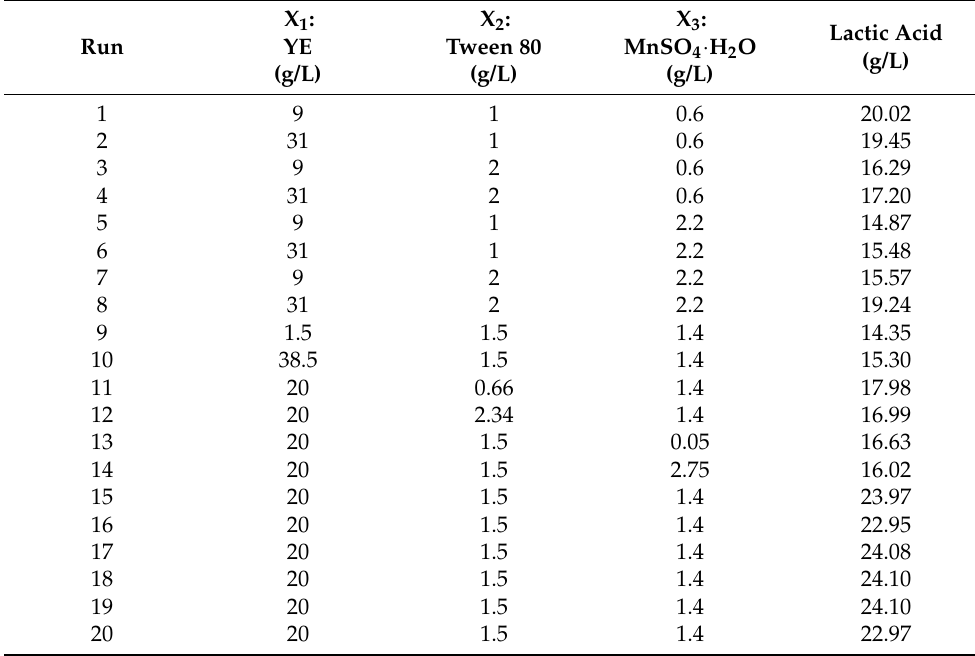
Table 4. Experimental designs and the experimental results of L -LA production responding to the